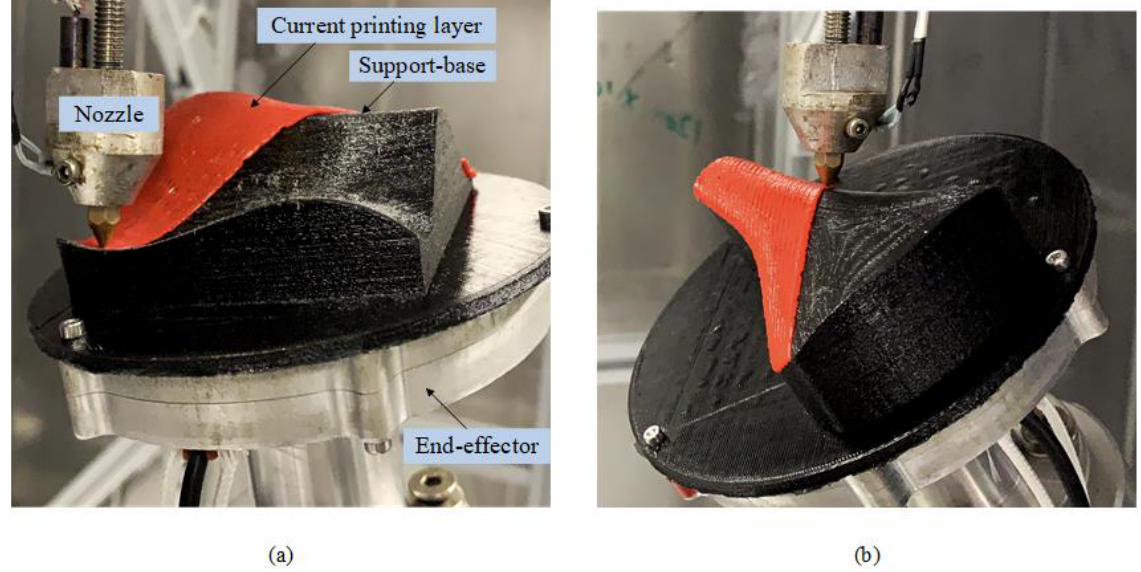
Figure 11. Snapshots of the physical printing experiments ( a ) Saddle surface 𝑆 1 and ( b ) Bicycle seat surface 𝑆 2 .